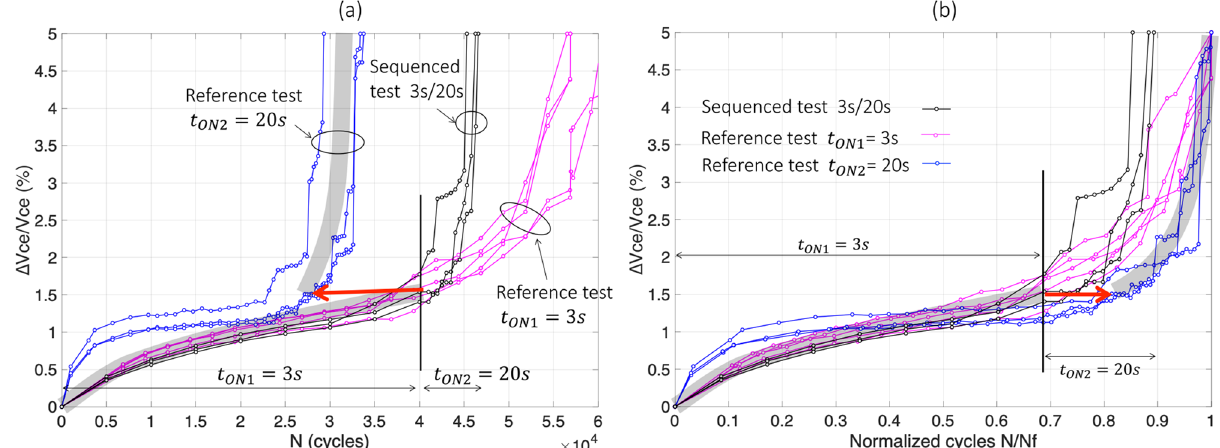
Figure 8. The sequenced test 3 s/20 s (test#9), normal scale in cycles ( a ) and normalized in N f ( b ).